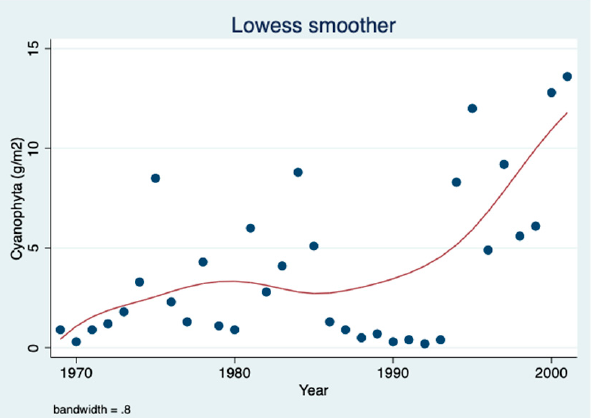
Figure 2. LOWESS smoother (0.8 bandwidth) trend of temporal annual mean changes of the biomass of cyanobacteria during 1969–2001 in Lake Kinneret.